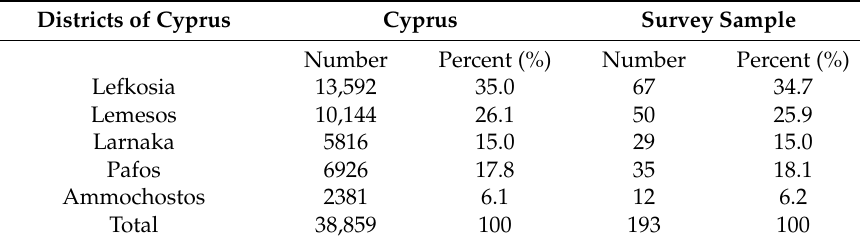
Table 1. Farm holdings in Cyprus and surveyed farm households by district. Districts of Cyprus Cyprus Survey Sample Number Percent